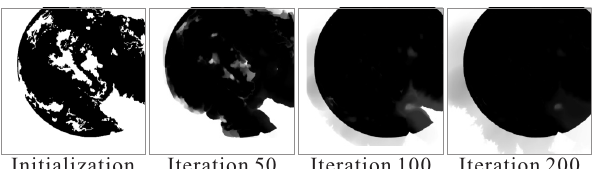
Fig. 7 The diffusion